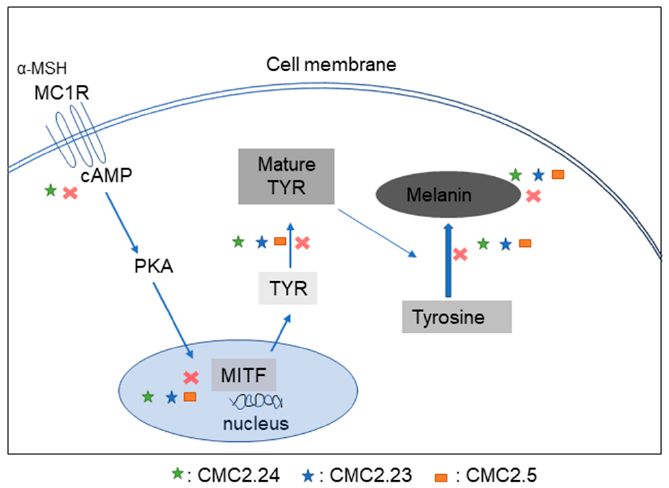
Figure 10. Proposed scheme showing the different targets at which CMCs inhibit the steps of melanogenesis in B16F10 cells.